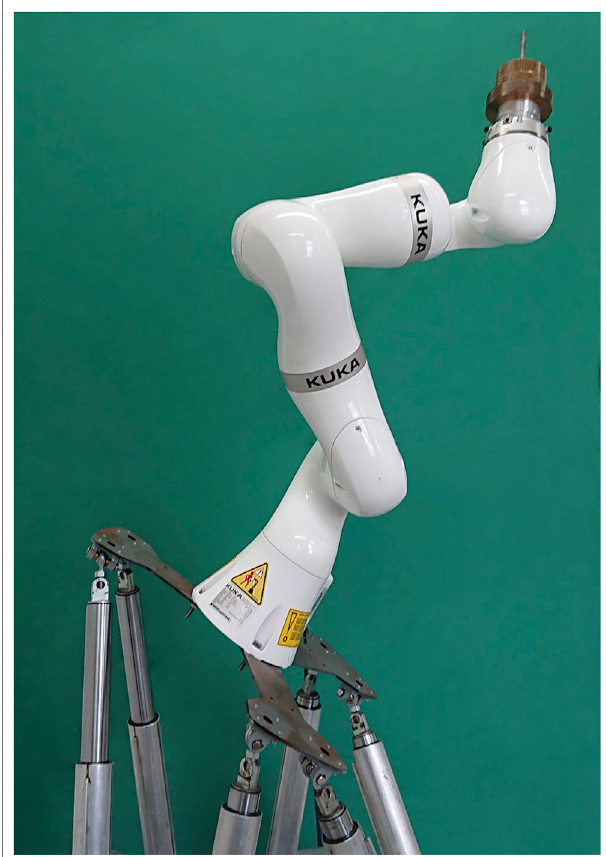
FIGURE3| TheLBRiiwawasmountedonahexapodtoacquirethetest data ( dataset gen , dir ), to evaluate the intra-directional generalization